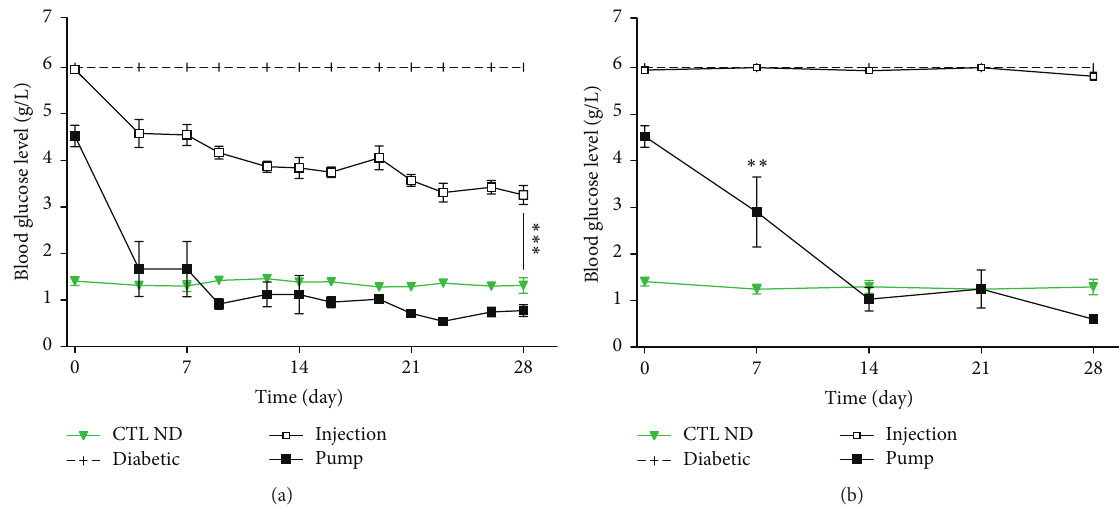
Figure 3: Blood glucose levels at 𝑡 + 5 h (a) and 𝑡 + 22 h (b) after insulin injection. At 𝑡 + 5 h, untreated rats (CTL ND and diabetic) had, respectively, normal glycaemia and 6 g/L glucose, the highest value detectable with our material. Pump rats succeeded in achieving normoglycaemia in a few days, whereas the injection group only reached ∼ 4 g/L. Diabetic group is different ( 𝑝 < 0.01 ) from all groups at all times. Injection group is different ( 𝑝 < 0.01 ) from all other groups at all times since day 4 ( 𝑝 < 0.01 ). Pump group is different ( 𝑝 < 0.01 ) from injection and diabetic group since day 4 (a). On a longer time ( 𝑡 + 22 h), CTL ND rats still had a normal blood glucose level, whereas the diabetic and injection groups levelled at 6 g/L. Pump rats still achieved normoglycaemia. Diabetic and injection groups are different ( 𝑝 < 0.01 ) from all groups at all times. ∗∗ 𝑝 < 0.03 pump versus CTL ND at day 7 (b). ∗∗∗ 𝑝 < 0.01